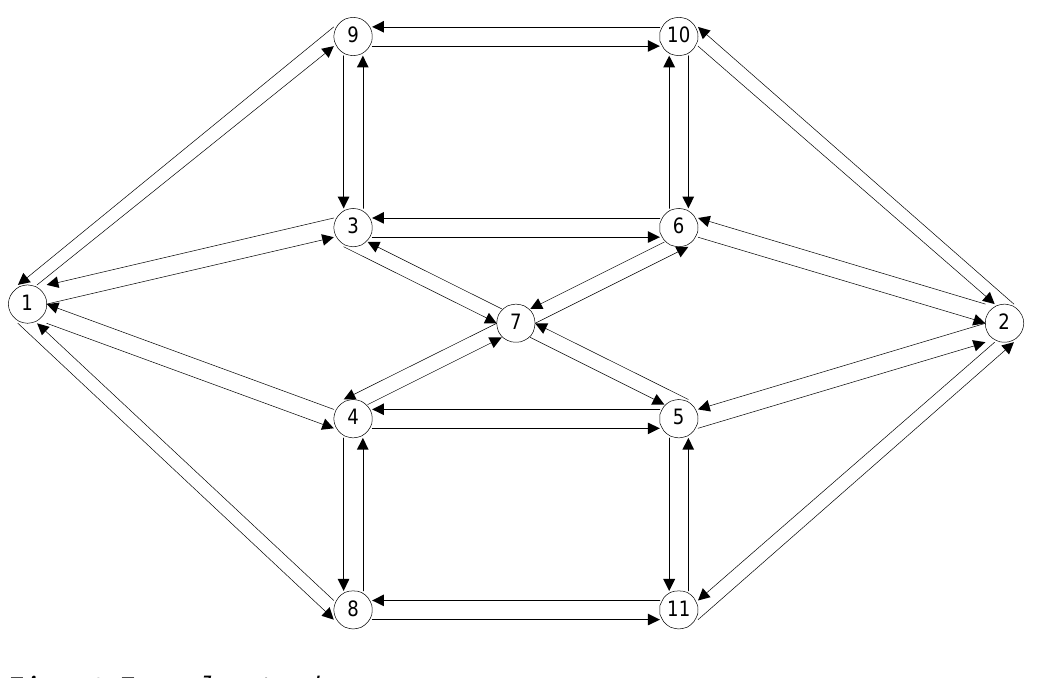
Figure1. Example